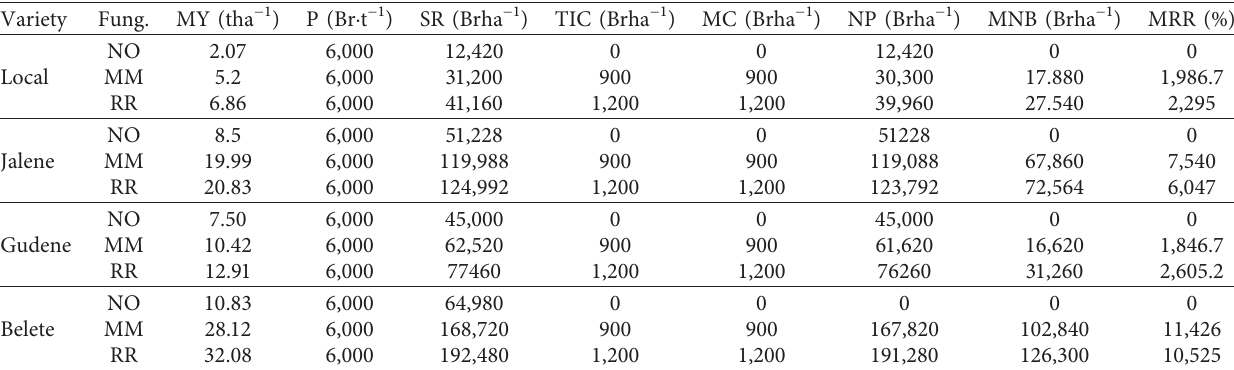
Table 8: Partial budget analysis for fungicide treated and untreated plots in controlling late blight of potato main cropping season. Variety Fung.